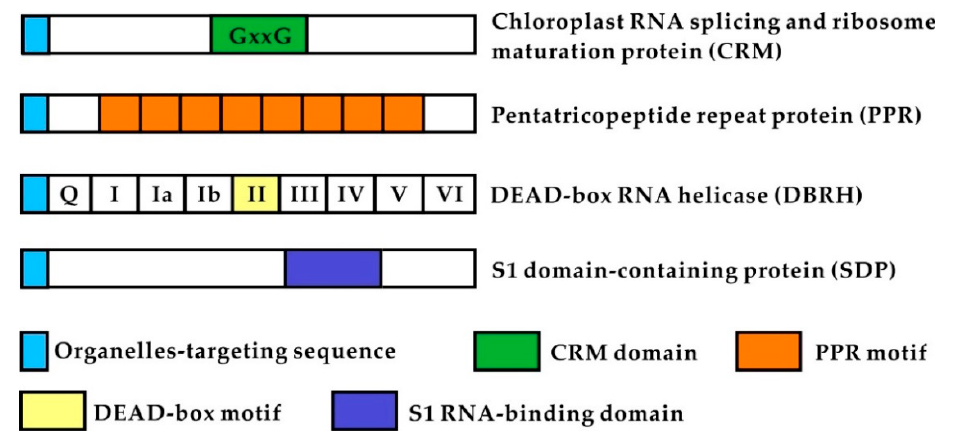
Figure 1. Basic domains or motifs of chloroplast ribosome maturation and splicing domain (CRM), pentatricopeptide repeat (PPR), DEAD-Box RNA helicase (DBRH), and S1-domain containing proteins (SDP) proteins in